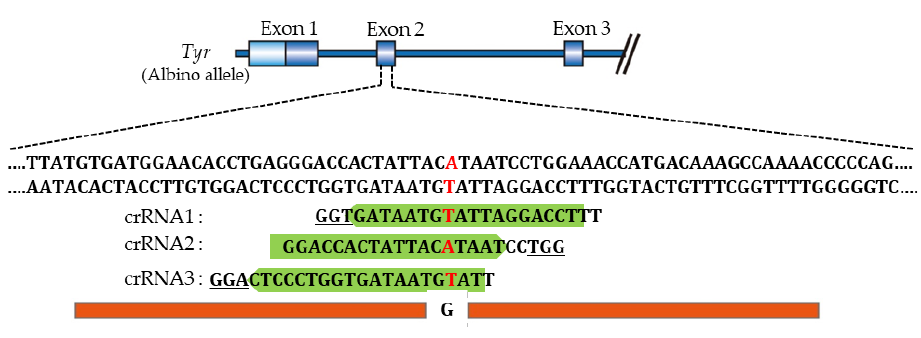
Figure 4. Schematic representation of knock-in (KI) experiment in rats toward the mutated Tyr locus performed by Aoshima et al. [141]. The target sequence (exon 2 of Tyr ) recognized by crRNA1, 2, and 3 is shown in green. The PAM sequences are underlined. Single-stranded oligodeoxynucleotide (ssODN) (containing wild-type nucleotide “G” that corresponds to mutated nucleotide “A”) is shown in orange below the target sequence. The nucleotide “A/T” marked in red is the mutation causative of the albino phenotype. This figure was drawn in-house, based on the data shown in the paper of Aoshima et al. [141].